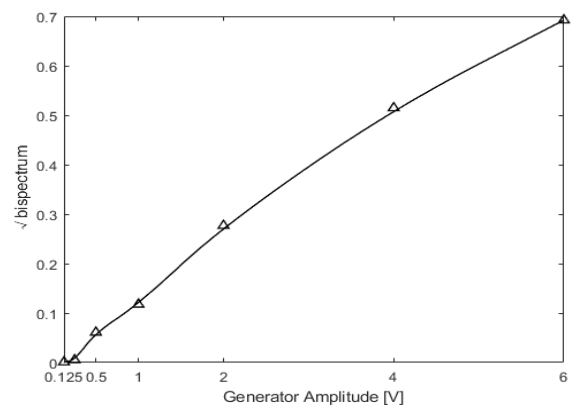
Figure 17. Variation trend of the second harmonic amplitude with the voltage.